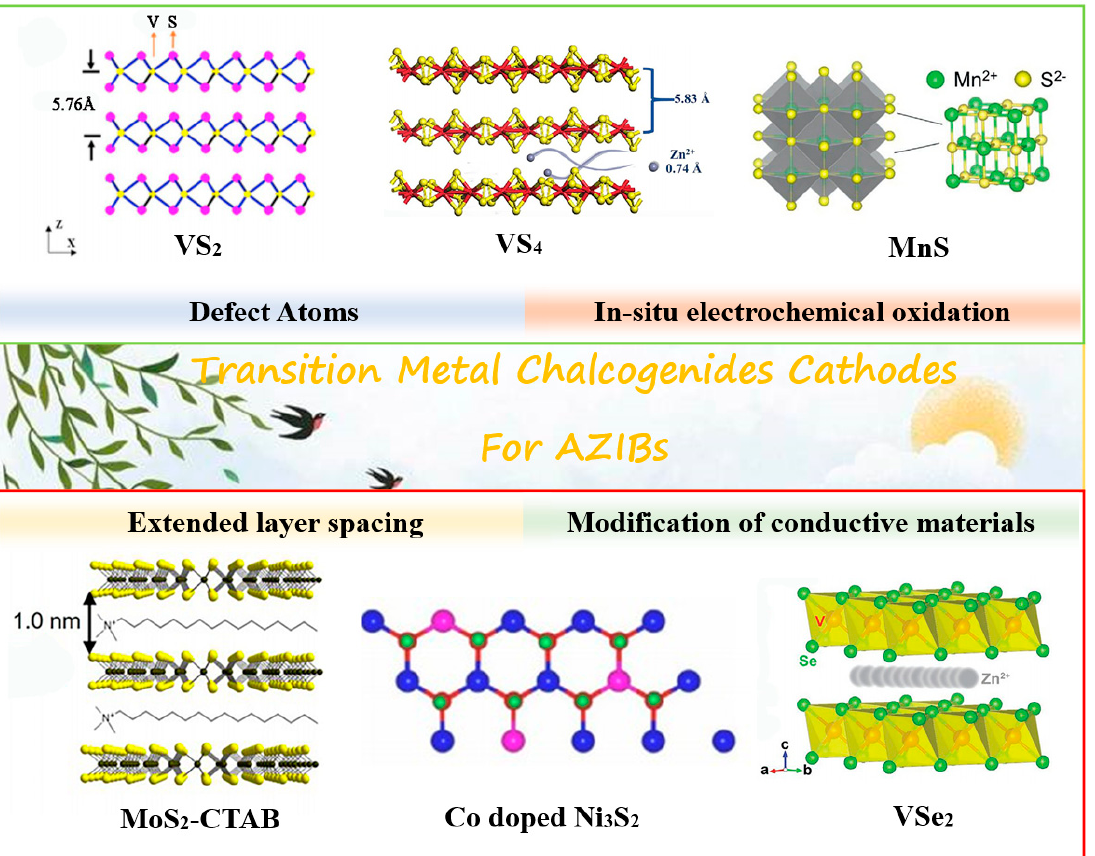
Figure 1. The classification of typical TMCs cathodes and the strategies of modification.